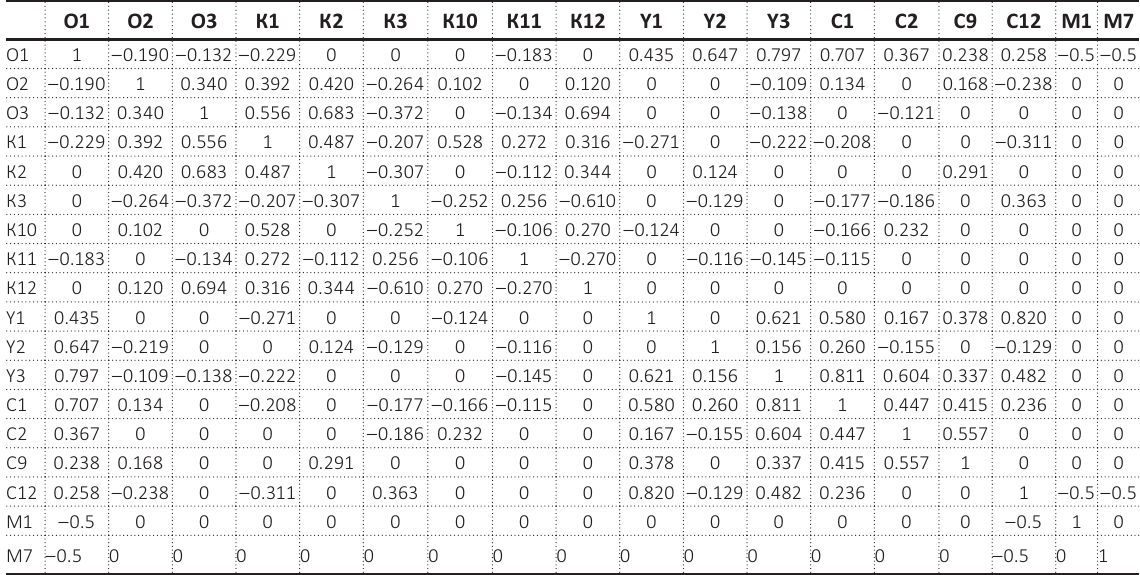
Table B1. Matrix of mutual impact on the acceptance criteria applied to banks acting as pension custodians due to the NBU’s measures and violations committed by banks in the field of financial monitoring, as well as potential actualization of network schemes (fragmentary presentation)